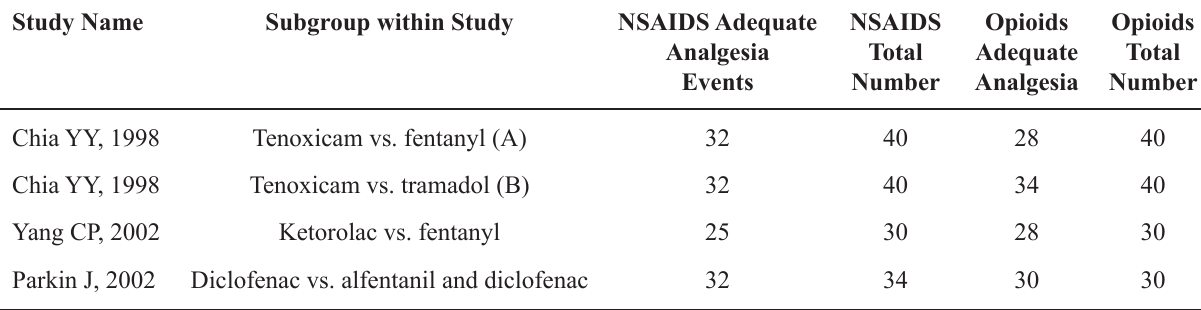
Table 1 – Non-steroidal anti-inflammatory drugs (NSAIDS) vs. opioids for pain relief in SWL using the electromagnetic shock wave